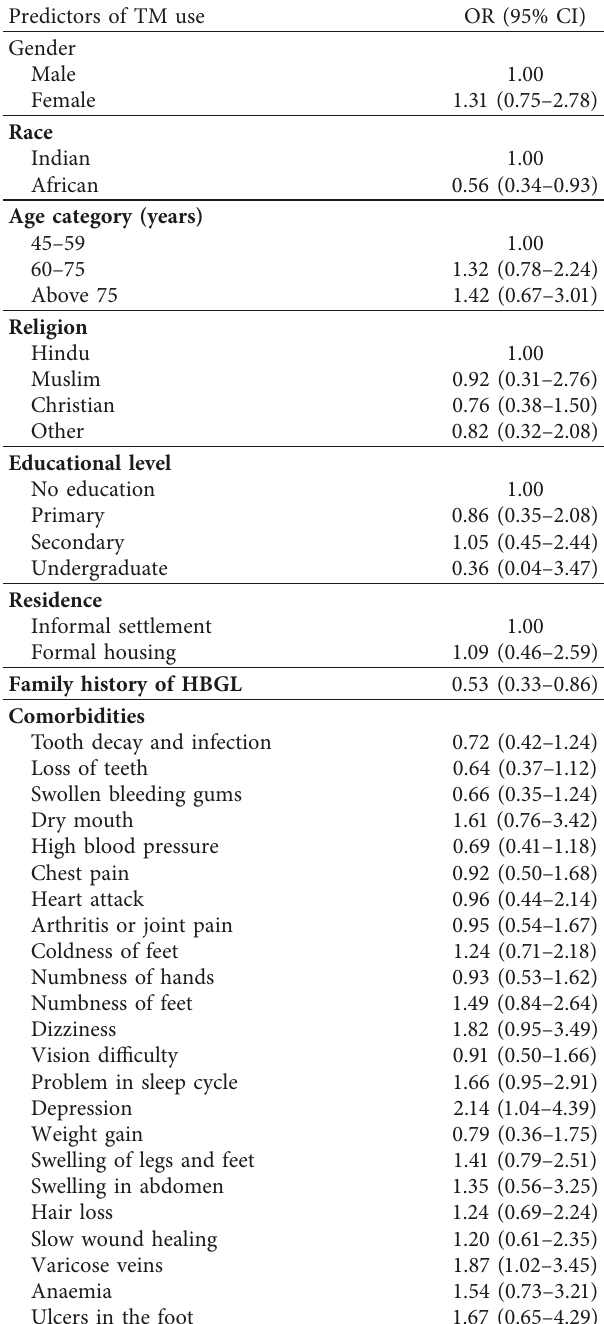
Table 6: Predictors of TM use among T2DM